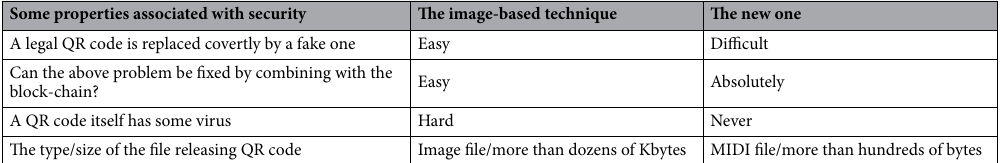
Table 9. Comparison of security between the image-based technique and the new